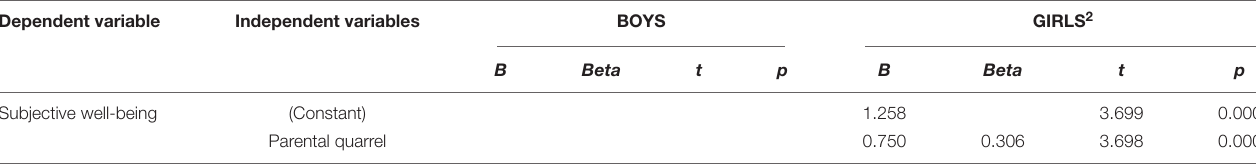
TABLE 9 | Multiple linear stepwise regression analysis of the study variables on subjective well-being among boys and